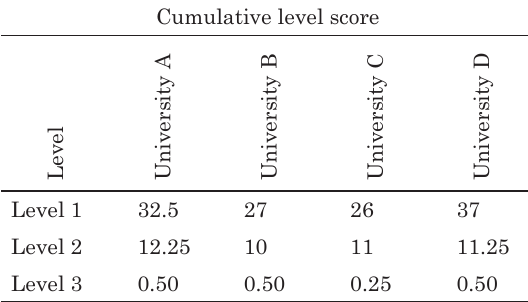
Table 3. Final scores by competency